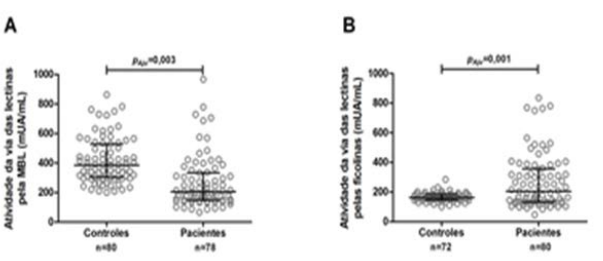
fIGuRE 2 – Functional assessment of lectin pathway activity in controls and patients with chronic Chagas disease